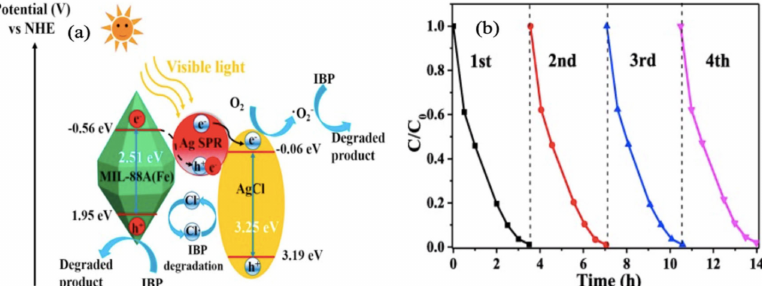
Figure 10. ( a ) Mechanism for photocatalytic degradation of ibuprofen using MIL-88(Fe) and Ag / AgCl@MIL-88(Fe) and ( b ) the reusability of the composites. Reproduced with permission from Reference